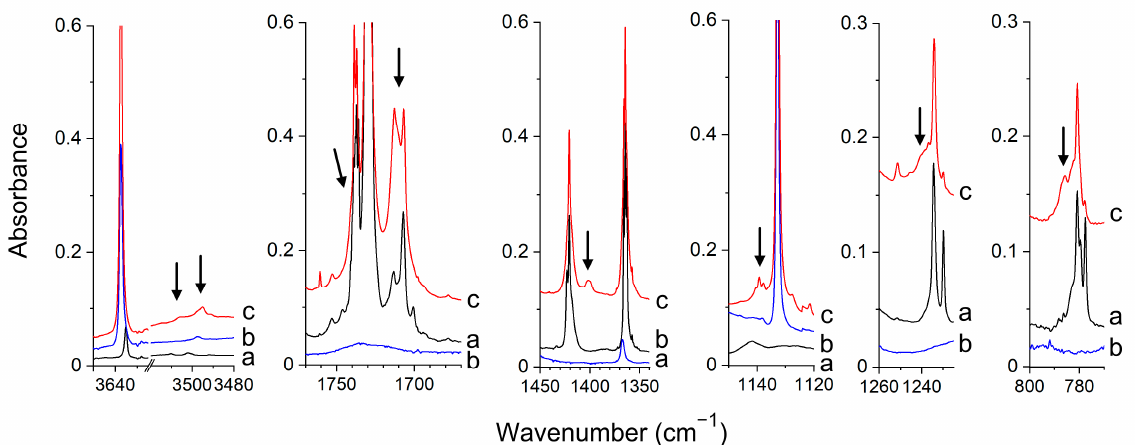
Figure 8. The spectra of the CH 3 COCHO/N 2 ( a ), NH 2 OH/N 2 ( b ) and CH 3 COCHO/NH 2 OH/N 2 ( c ) matrices recorded after matrix deposition at 11 K. The bands of CH 3 COCHO–NH 2 OH complex are indicated by the arrows.